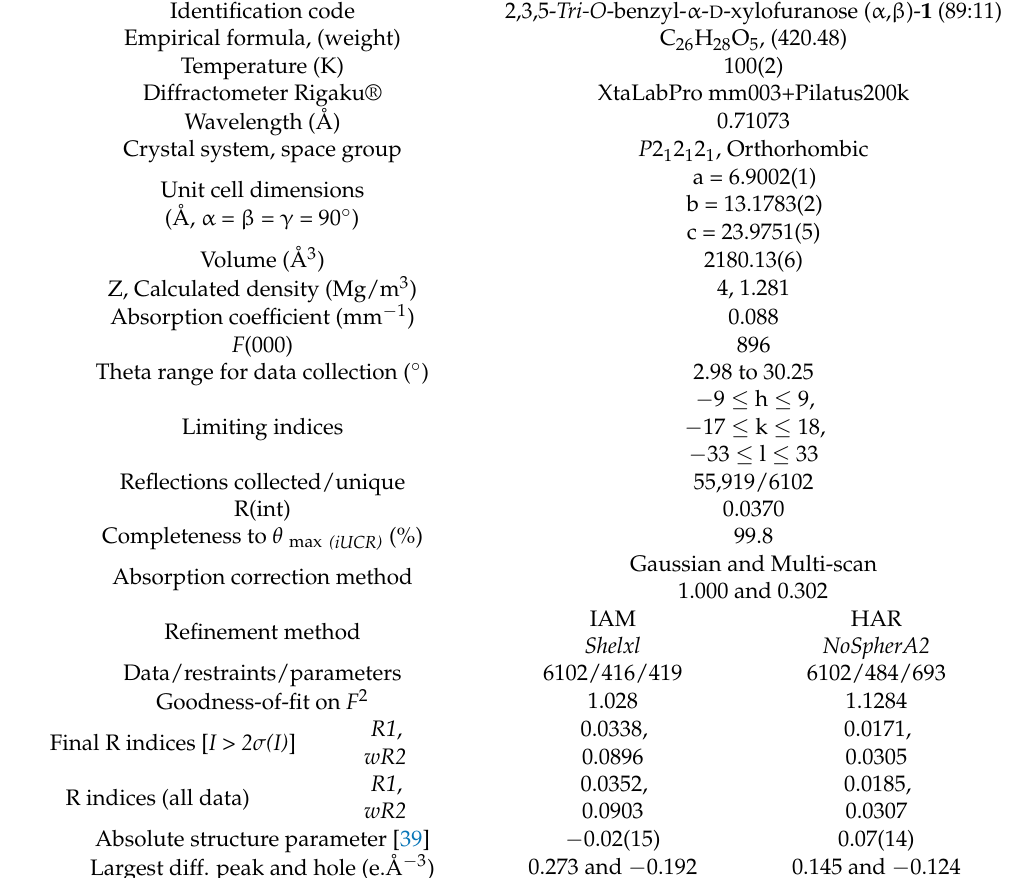
Table 3. Crystal data, data collection and structure refinement details of compound 1